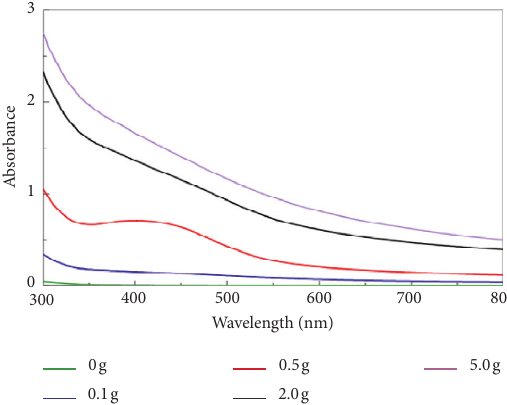
Figure 6: UV-vis spectra of reaction solutions with different amounts of SiO